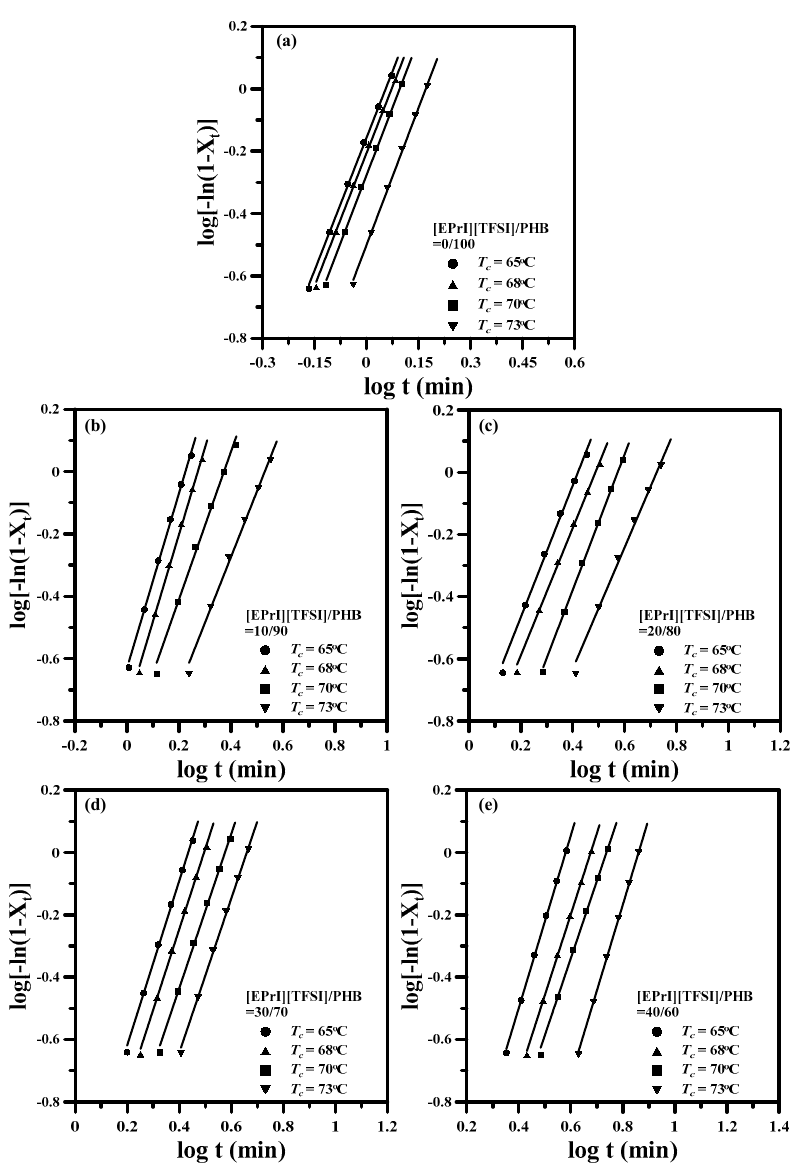
Figure 4. Avrami plots for isothermal crystallization of [EPrI][TFSI]/PHB blends with different compositions: ( a ) 0/100; ( b ) 10/90; ( c ) 20/80; ( d ) 30/70; and ( e ) 40/60 (crystallization temperatures are indicated in each graph).